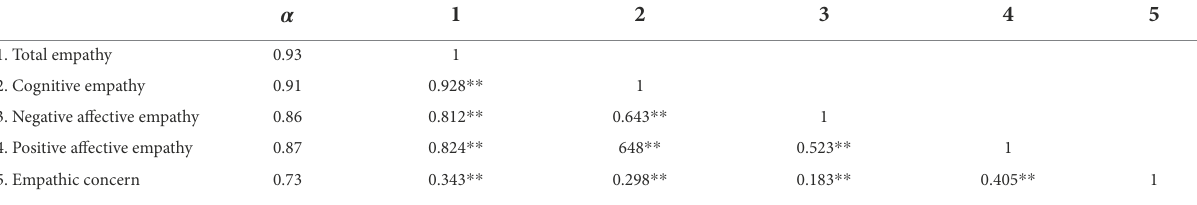
TABLE 6 EST convergent validity and internal consistency reliability (n =